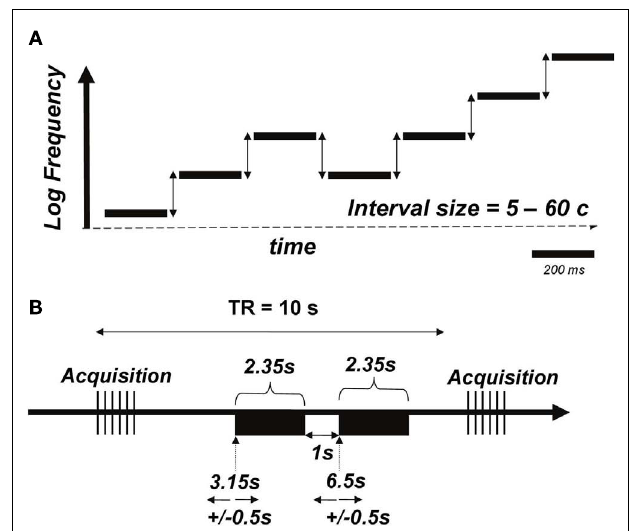
FIGURE 2 | (A) Schematic of the micromelody stimuli. Each of seven tones was generated such that there would be two or three inversions of melodic contour; the middle tone was set at 250Hz for the training stimuli (or 500 or 1150Hz for pre- and post-training generalization testing).The intervals between notes (vertical arrows) was varied parametrically between 5 and 60cents. Sound files (attached) provide examples of the stimuli; the first file corresponds to a micromelody with 5cents intervals, the second with 20cents intervals, and the third with 60cents intervals. (B) Schematic of the functional MRI acquisition protocol. A pair of micromelodies (denoted by black rectangles) was presented in the quiet interval between volume acquisitions using a 10-sTR. Onsets of the first and second melodies occurred at 3.15 and 6.5s, respectively, with an additional jitter of 0.5s